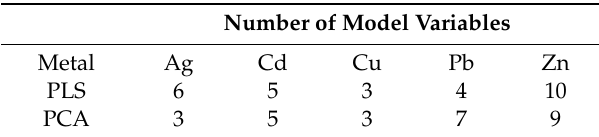
Table 2. Principal component values for the Partial Least Square (PLS) and Principal Component Analysis (PCA) models based on ATR FT-IR data